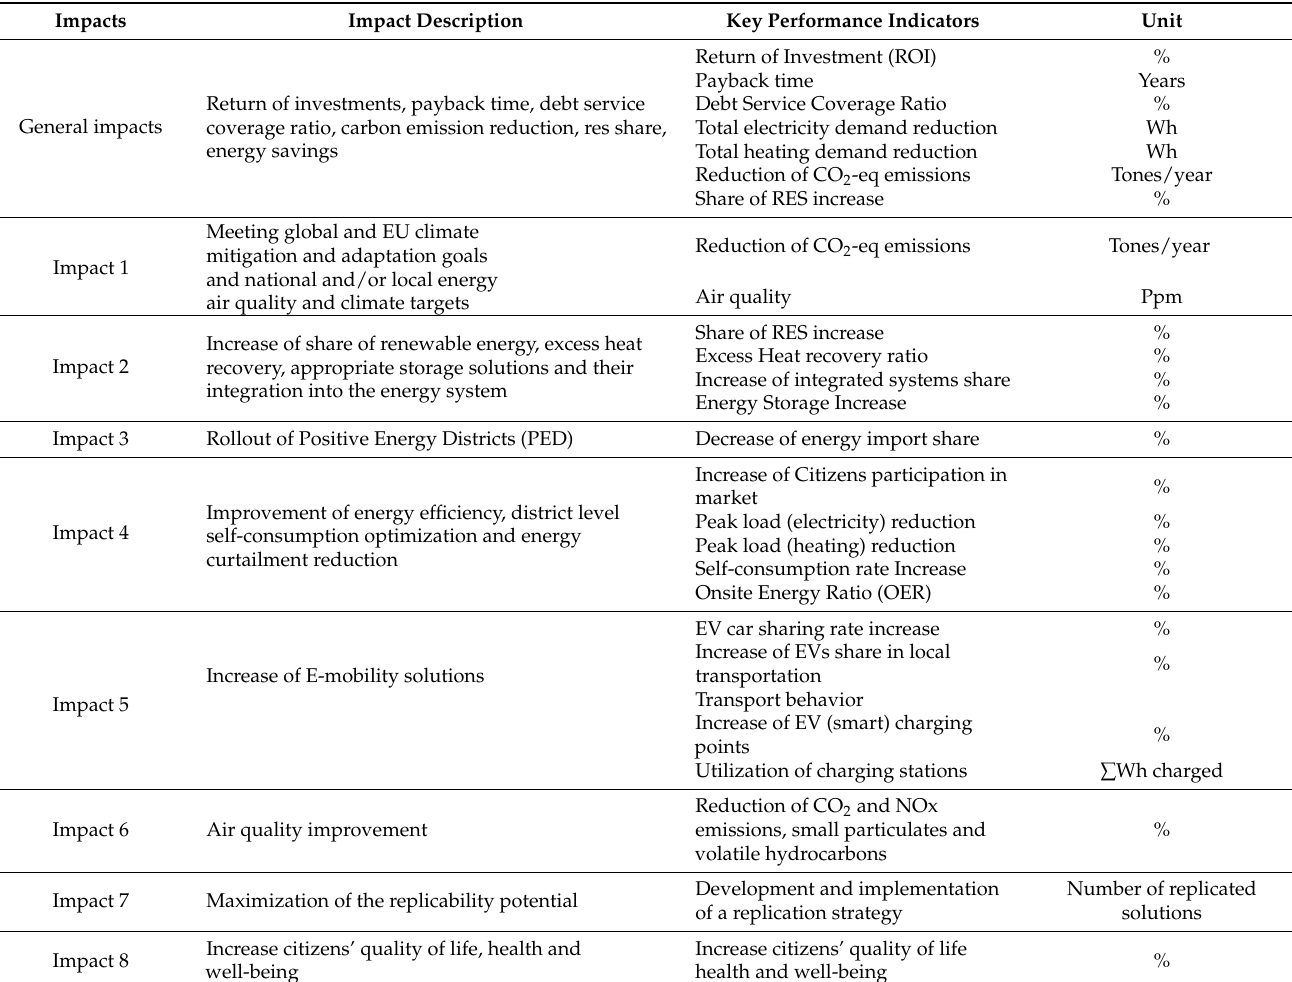
Table 3. Top-down